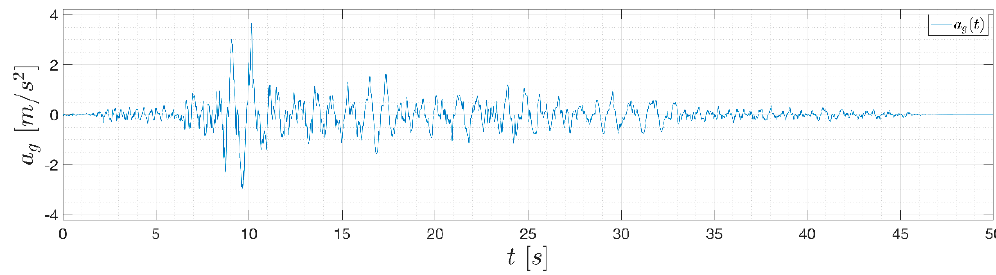
Figure 2. Montenegro (1979) ground motion record with peak ground acceleration (PGA) = 3.59 m/s 2 .